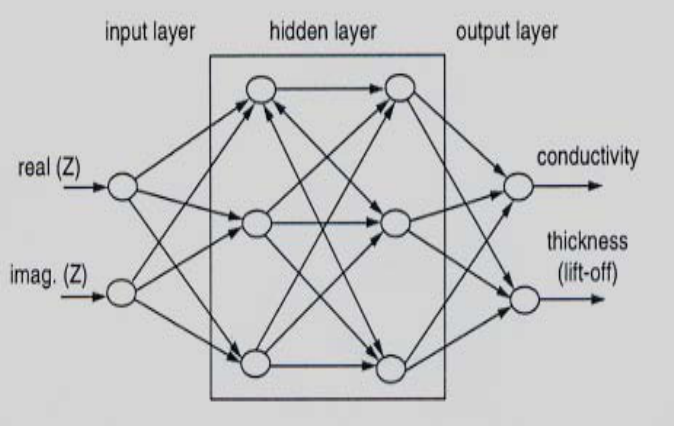
Figure 29. Neural network aided property estimation.